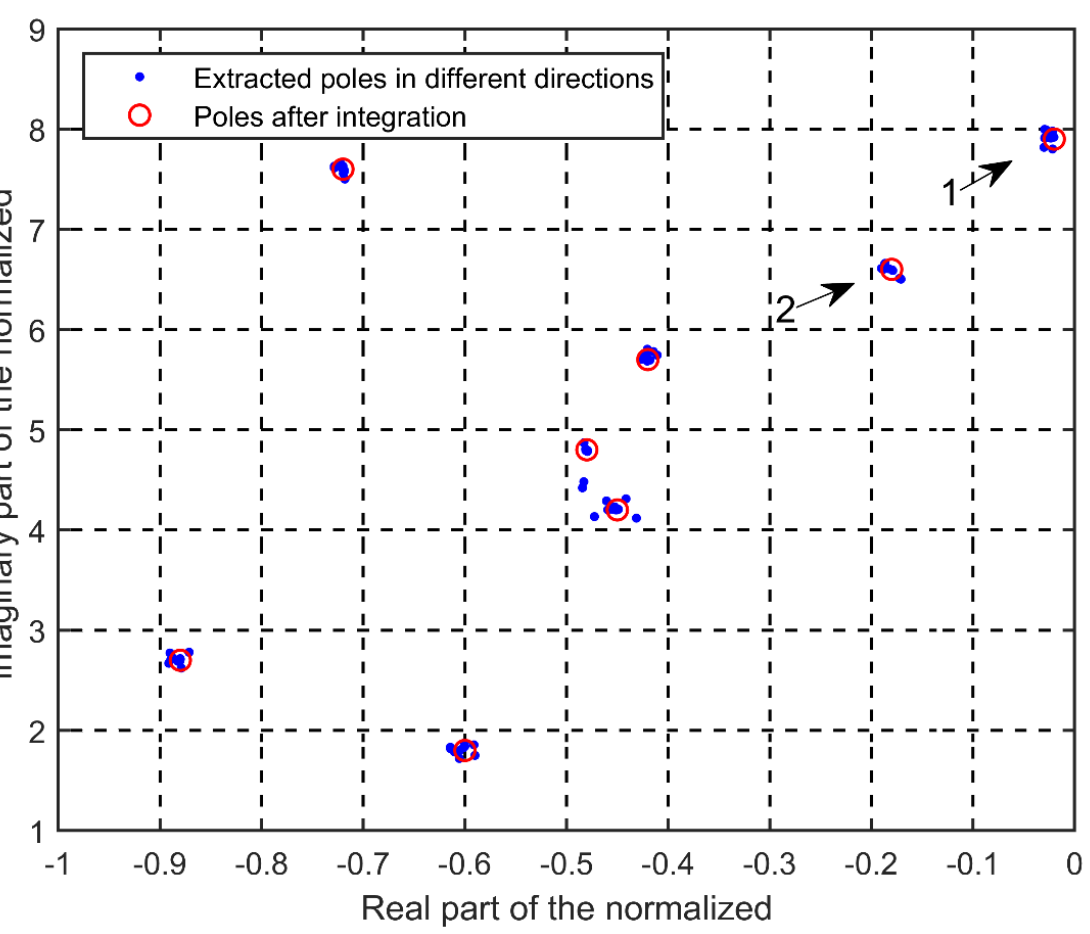
Figure 5. Extracted poles distribution along ten directions using the method proposed in this study. The blue marks are the original poles extracted in ten directions and the red marks are the poles obtained after correction.